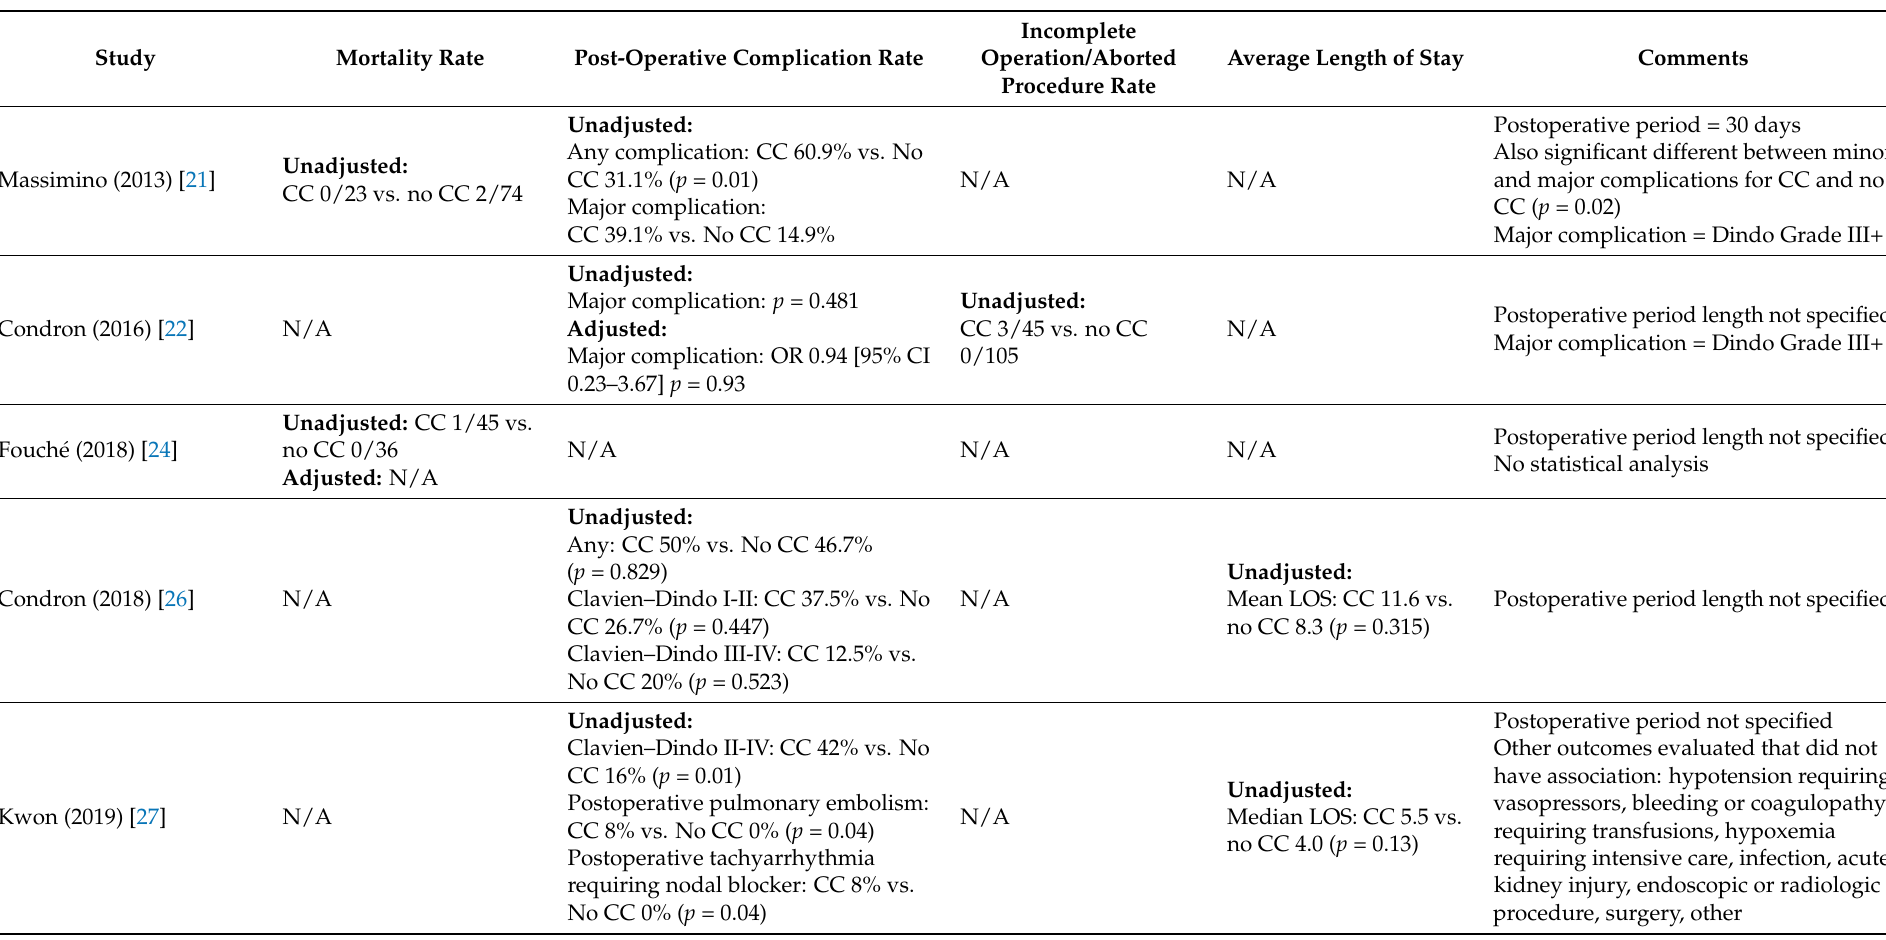
Table 4. Prognosis of carcinoid